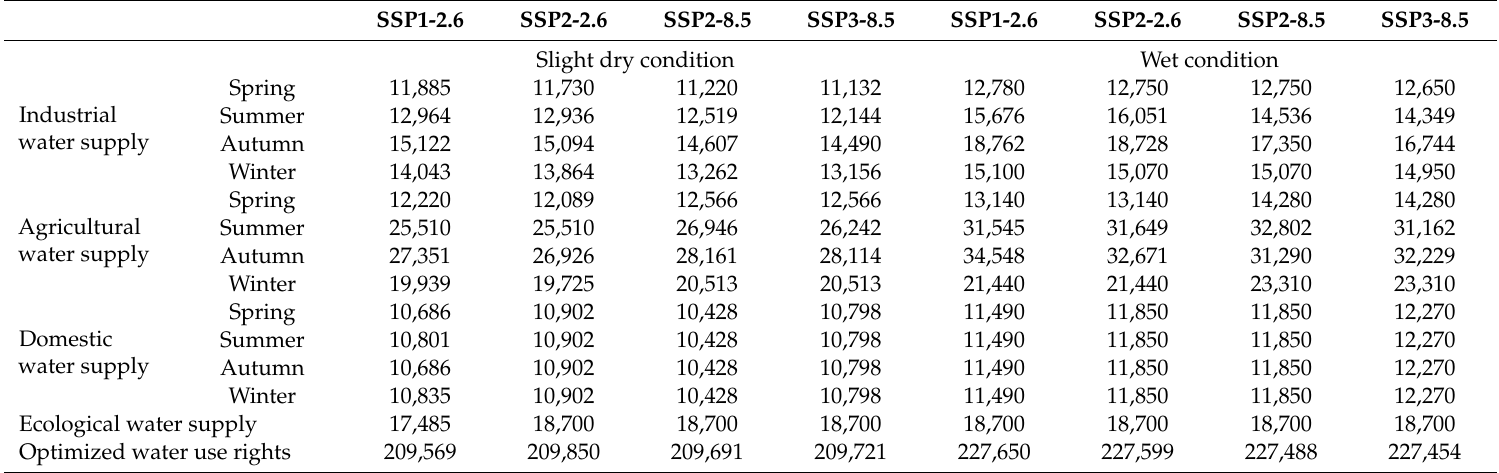
Table 6. Water supply with varying available water in Henan province (ten thousand m 3